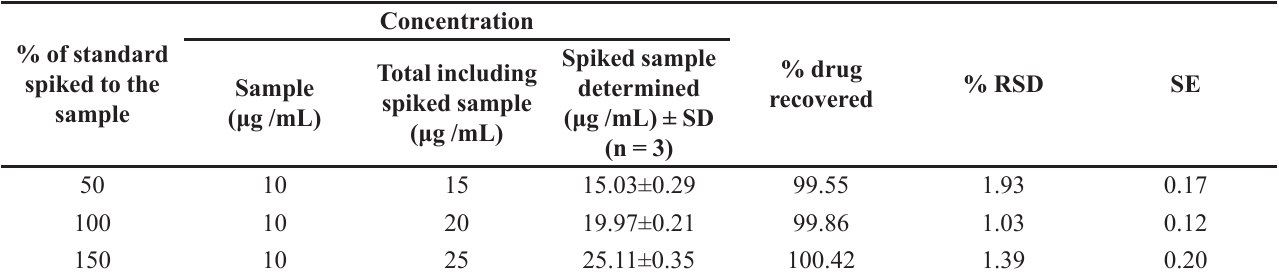
TABLE I - Accuracy as recovery of proposed method